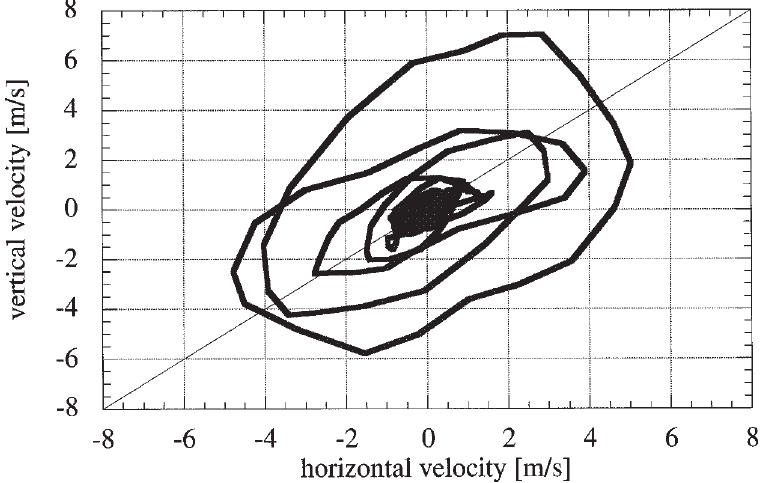
Fig. 9. Trajectories of the vertical/horizontal